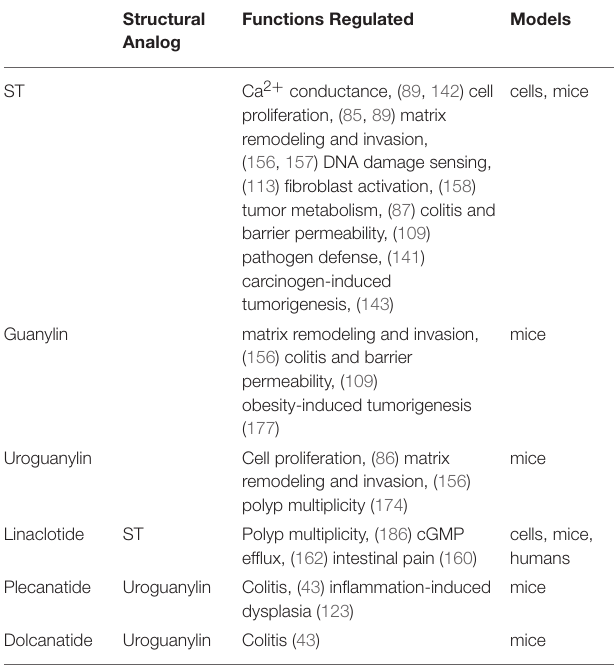
TABLE 2 | GUCY2C agonists shown to oppose tumorigenic cell circuits. Structural